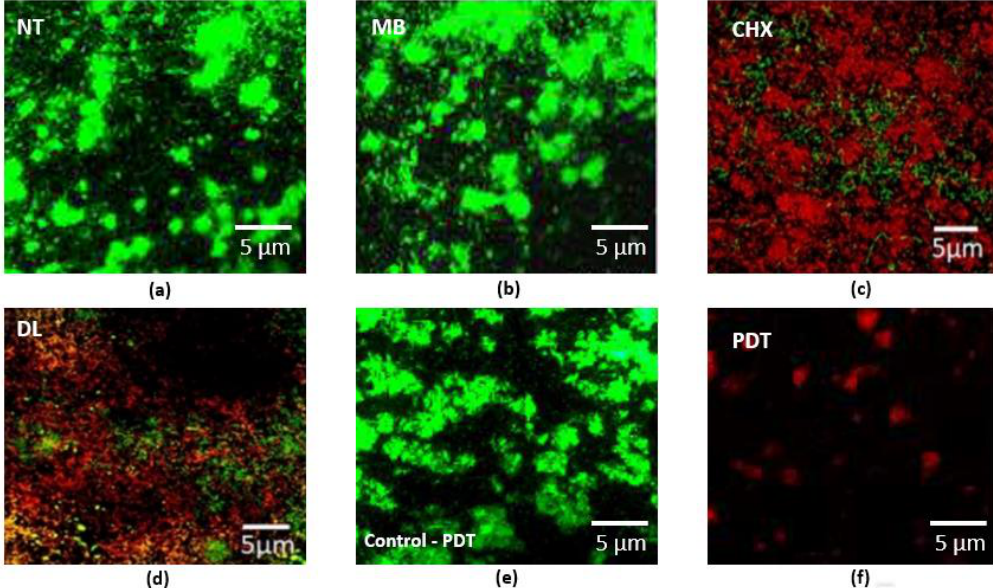
Figure 2. Representative CLSM images of periodontal bacteria grown on PICN discs are shown. ( a ) The control specimens with no treatment (NT) and ( b ) MB specimens are shown as green densely clustered colonies with almost no areas of dead cell; ( c ) represents data for CHX treated specimens. The bacteria in the CHX and ( d ) DL groups appeared dead with few areas of surviving green stained bacteria, indicating survivability; ( e ) Specimen from PDT group before decontamination (control for PDT) and ( f ) post decontamination indicating the highest dead cell count and destroyed bacteria that could be removed after treatment.